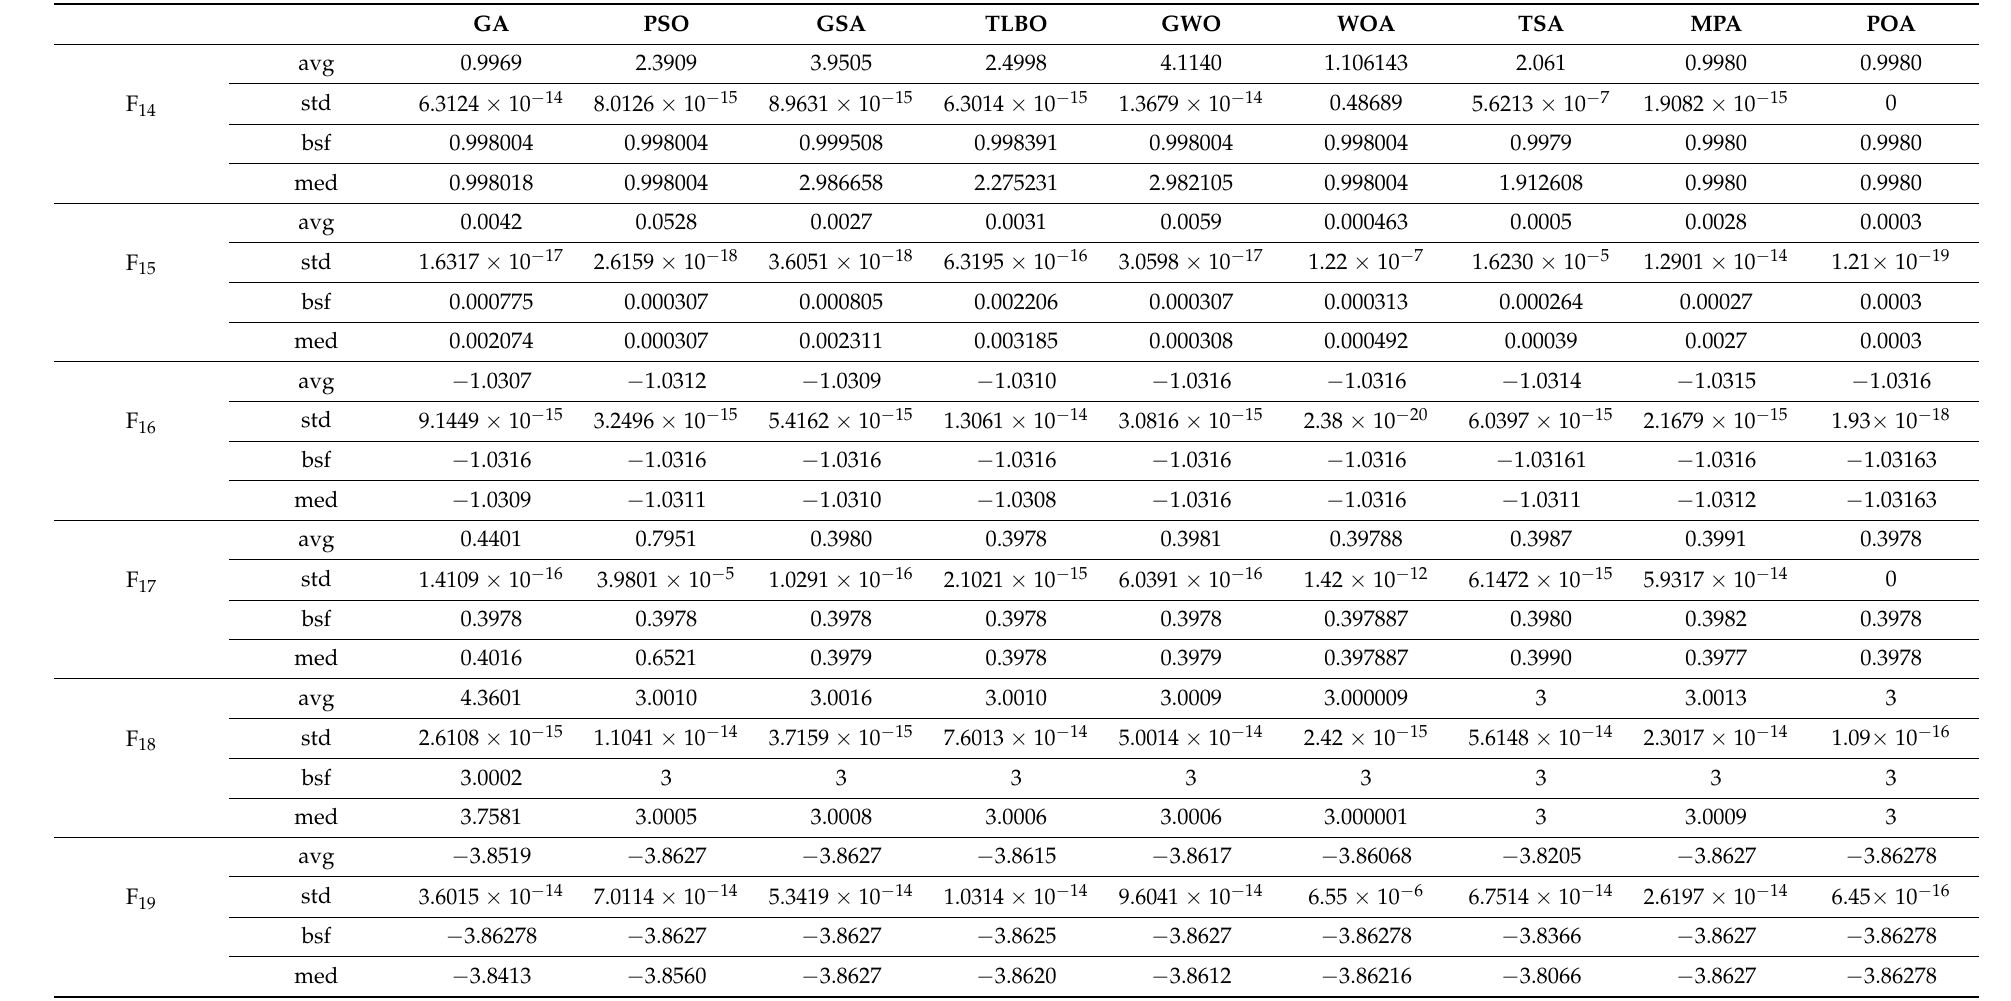
Table 4. Evaluation results of fixed-dimensional multimodal